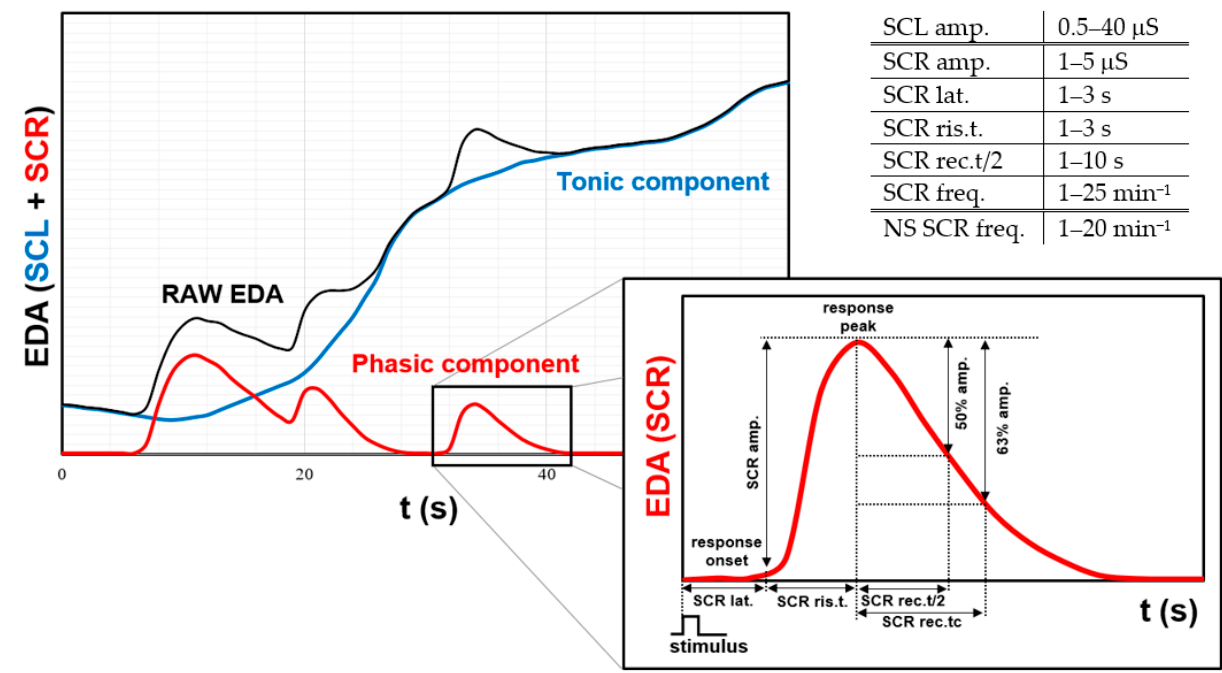
Figure 1. Typical EDA response.